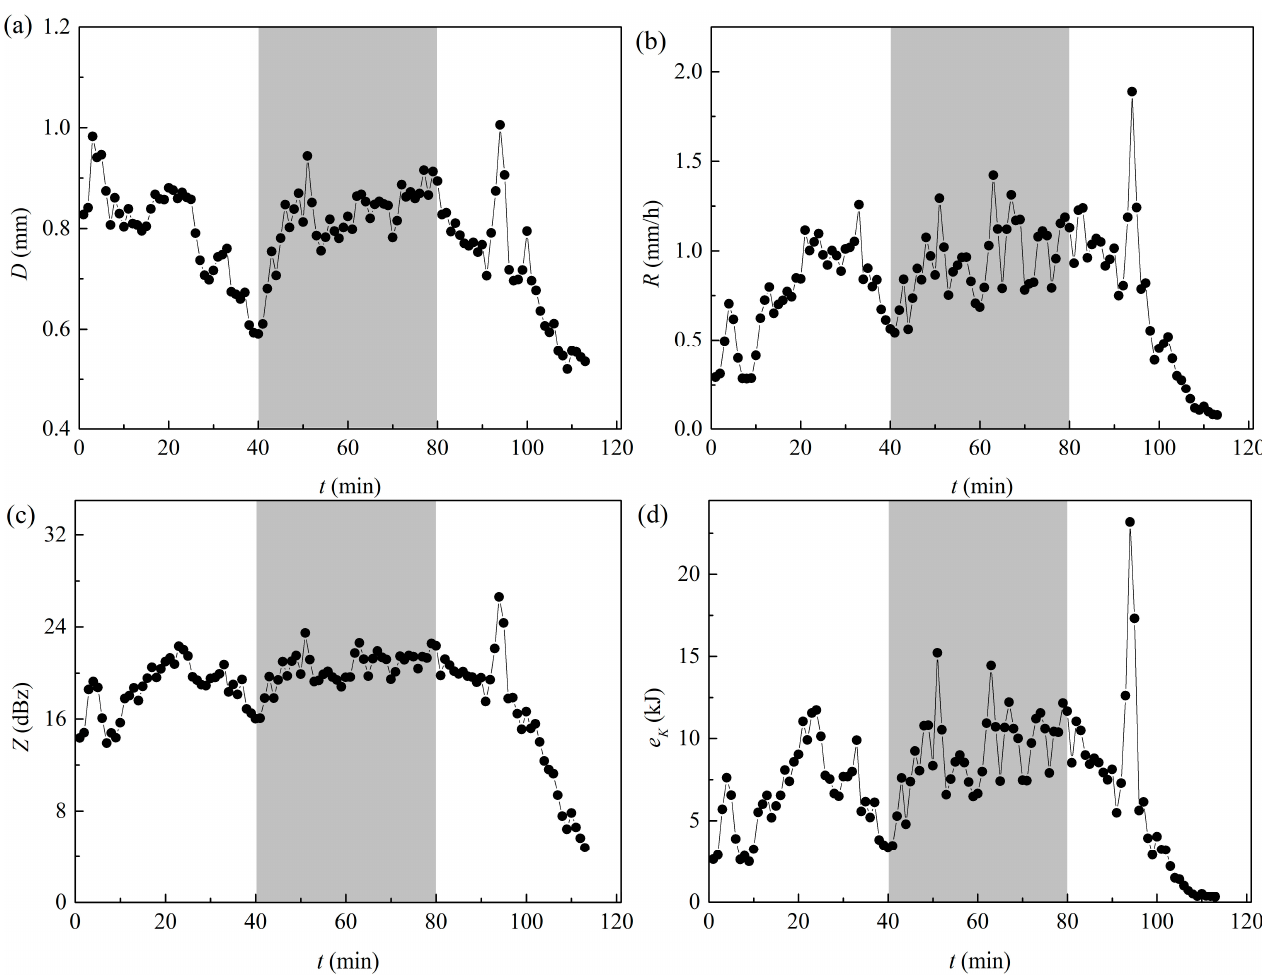
Figure 12. Temporal evolution of ( a ) D , ( b ) R , ( c ) Z , and ( d ) e k measured by OTT at the field site.